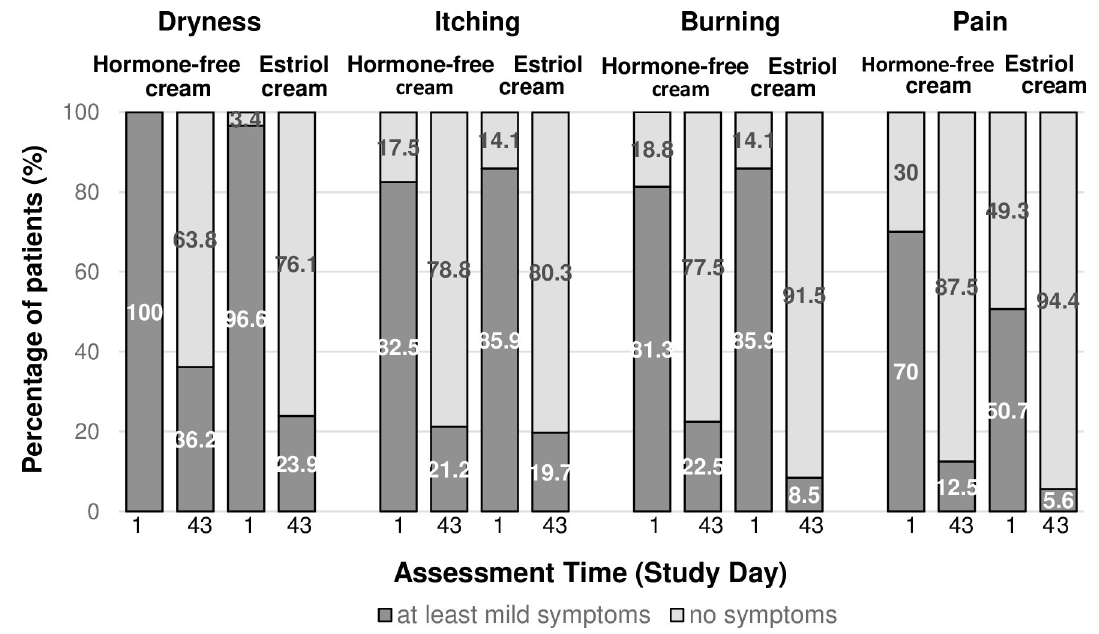
Fig 3. Vulvovaginal subjective symptoms at baseline. Percentage of patients suffering from at least mild subjective symptoms or free of symptoms. Number of patients (PP): Hormone-free moisturizing cream n = 80; Estriol cream n = 71.